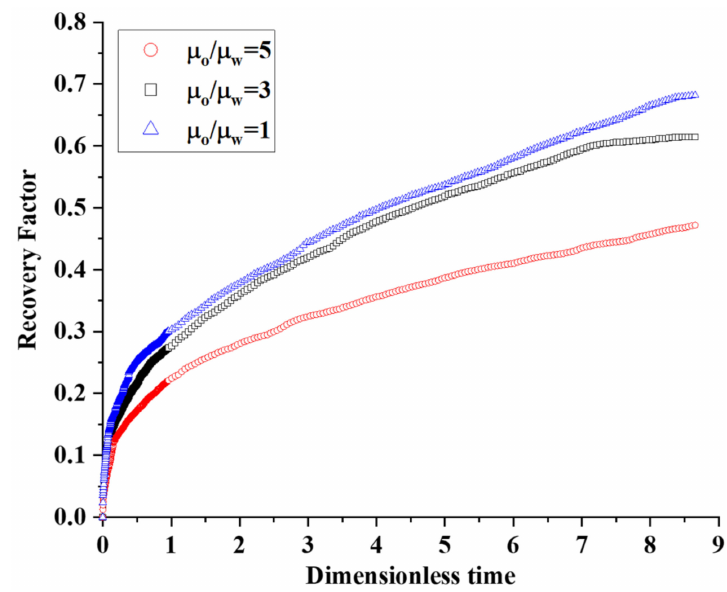
Figure 22. Recovery factor with different oil-water viscosity ratios.